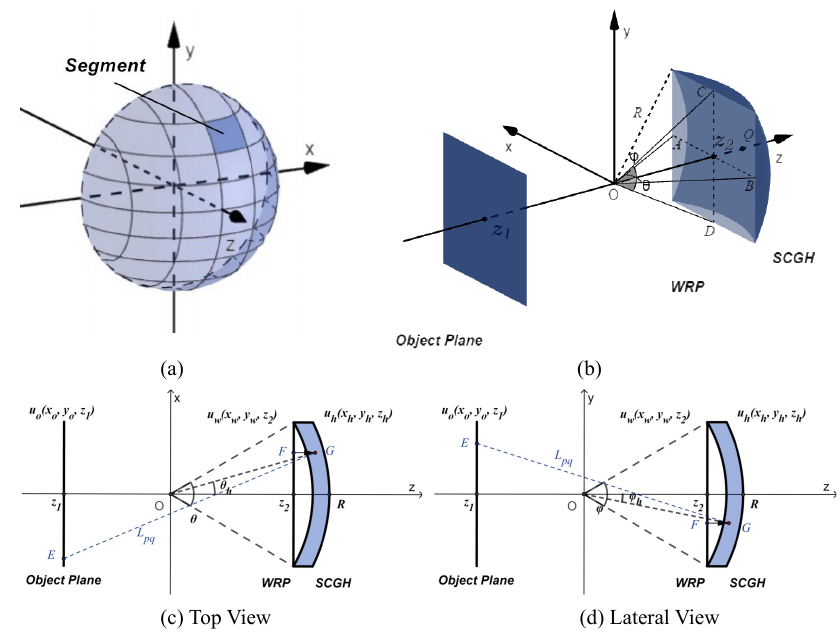
Figure 1. Panels ( a , b ) represent for the propagation model between plane and sphere; panels ( c , d ) are schematics of spherical computer-generated hologram (SCGH) generation by phase compensation (PC)